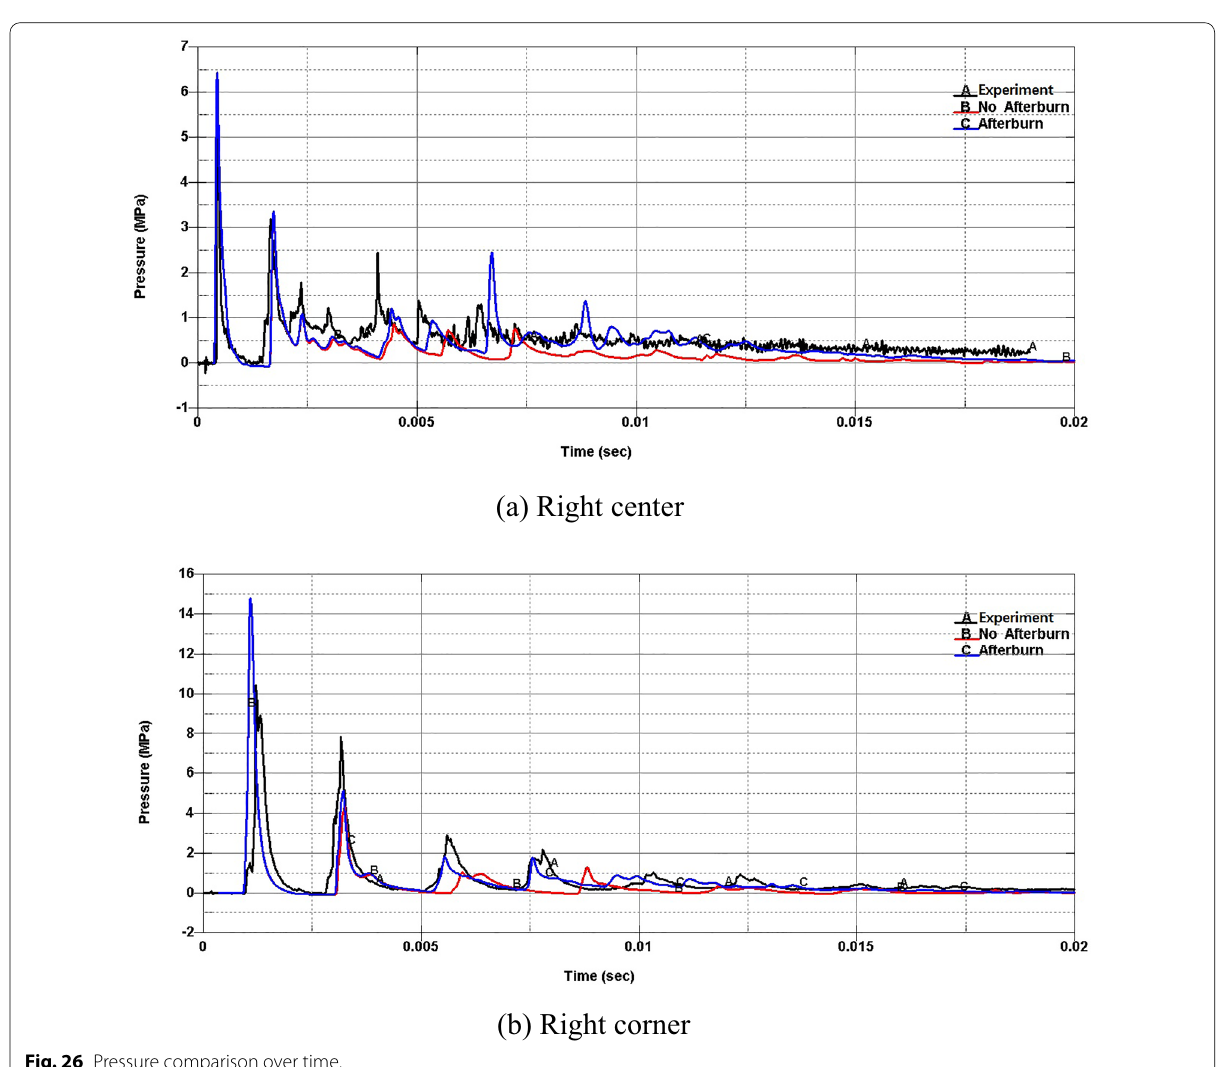
Fig. 26 Pressure comparison over